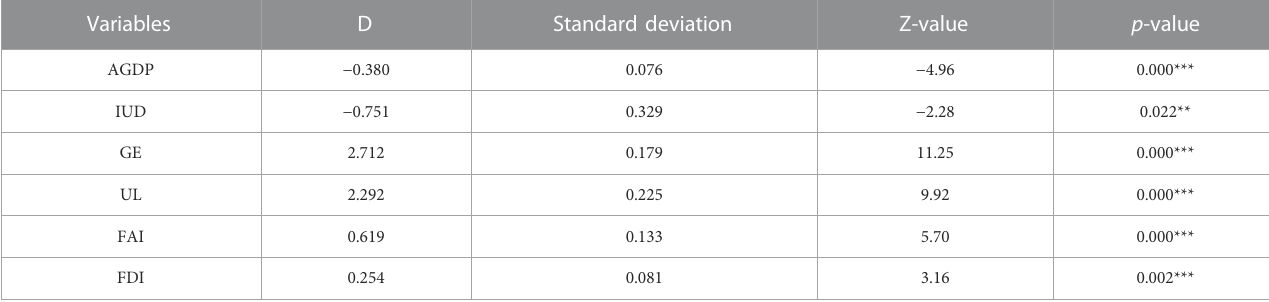
TABLE 3 Logit regression analysis of treatment variables on control